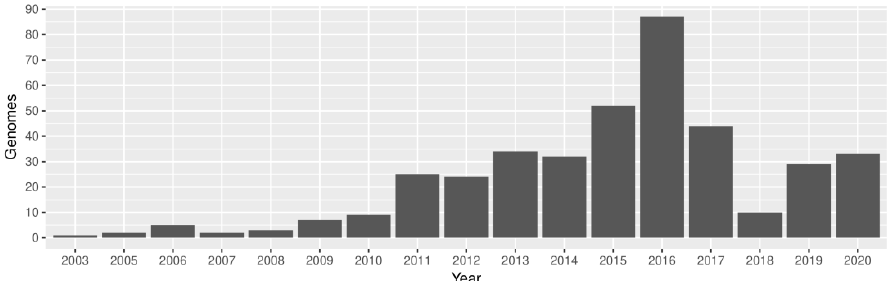
Figure 1. Brazilian regions and distribution of Klebsiella genomes. The values represent the amount of Klebsiella genomes obtained from each Brazilian state. The Brazilian regions are colored in green (North), red (Northeast), yellow (Midwest), lilac (Southeast), and blue (South).